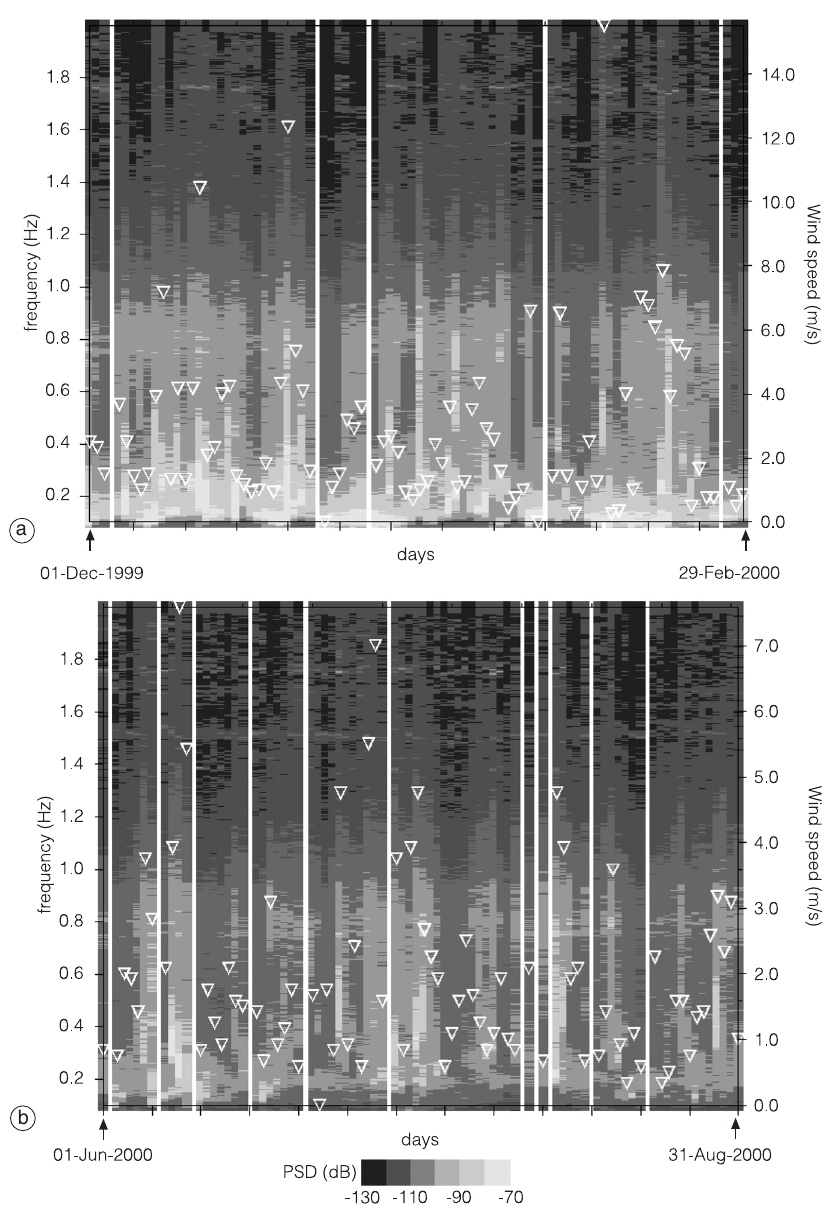
Fig. 10a,b. Spectragrams for: a) 1st December 1999 to 29th February 2000; b) 1st June 2000 to 31st August 2000. The E-W component PSD daily variation from noise samples at 3 AM local time for the frequency band 0.1 < f < 2 Hz is shown. A correlation between hourly averaged wind speed (white triangles) and seismic background noise is observed (note the change in wind speed scale in (b) with respect to (a)). White vertical stripes indicate days for which there is no